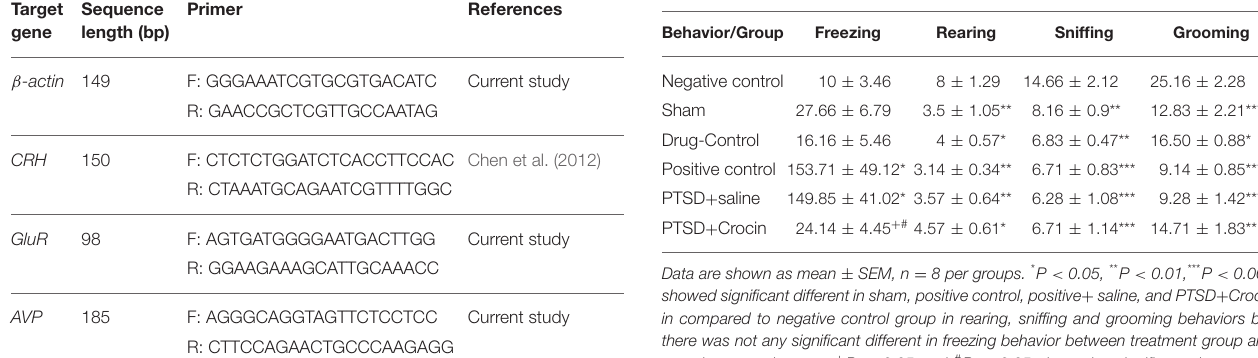
TABLE 2 | Effects of ICV administration of crocin on dopamine-dependent behaviors in rats 21 days after electric foot shock stress